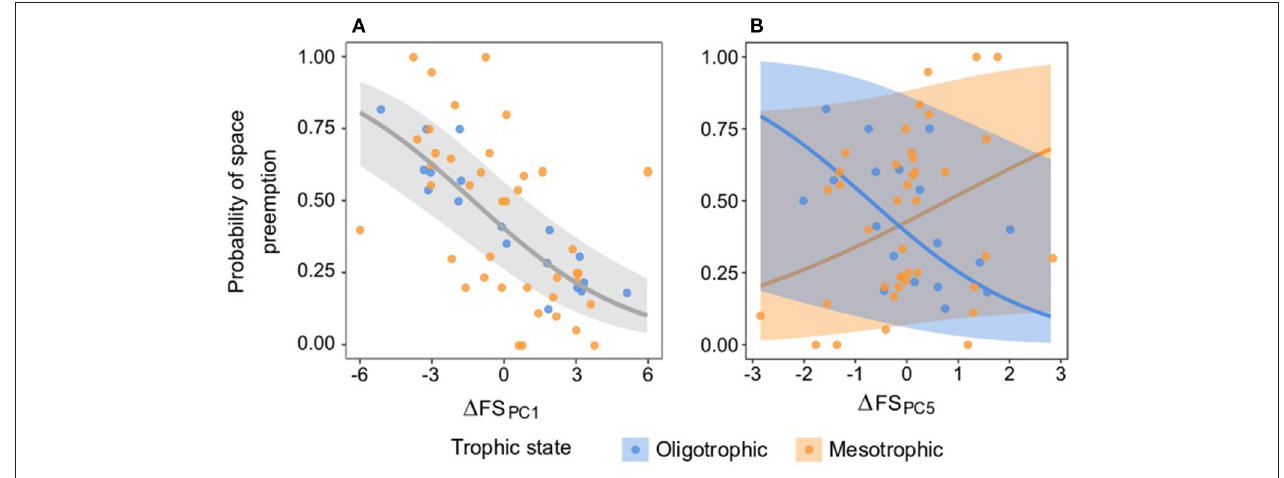
FIGURE 8 | Relationship between the difference in the functional strategy of a pair of species on PCs 1 (A) and 5 (B) ( 1 FS PC1,5 ) on the probability of space preemption of species A on species B. The points represent the empirical space preemption for each seagrass species pair. (A) The gray line represents the predicted preemption according to 1 FS PC1 and the light gray ribbons the confidence interval of the prediction. Model equation for 1 FS PC1 : p i = − 0.391 − 0.301 • 1 FSPC 1. (B) The blue and orange lines represent the predicted preemption per trophic state according to 1 FS PC5 , and the light blue ln 1 − p i (cid:17) (cid:16) and orange ribbons the confidence intervals of the prediction. See Supplementary Material 8 for the regressions in the other PCs.